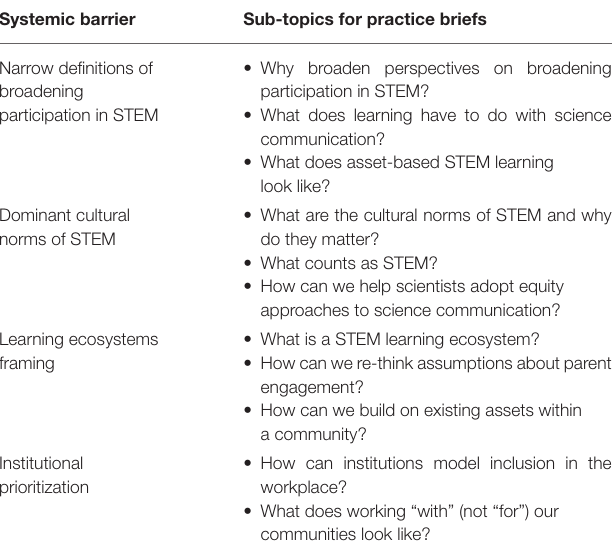
TABLE 1 | Barriers and